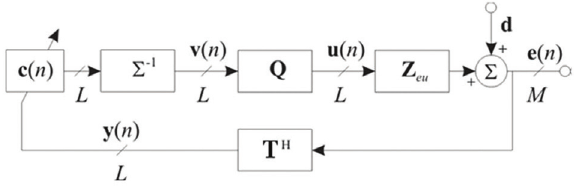
Fig. 6. Block diagram of principal component LMS algorithm in the complex frequency domain, with L actuators and M